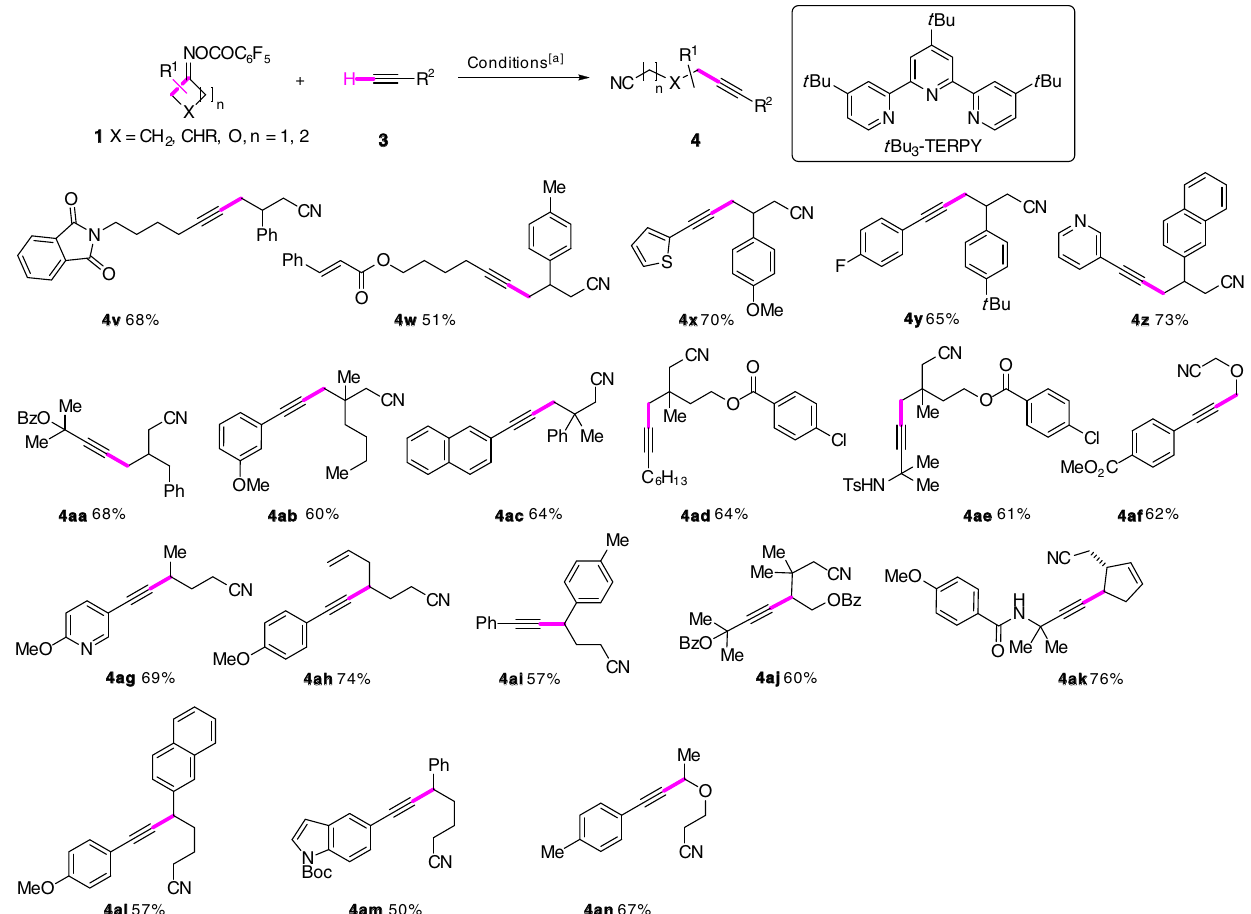
Fig. 3 Cu-catalyzed reductive coupling of oxime esters derived from cycloalkanone derivatives. [a] 1 (0.2 mmol), 3 (0.4 mmol), CuI (0.1 equiv), t Bu 3 - TERPY (0.2 equiv), K 2 CO 3 (2.0 equiv), CH 3 CN (1.0 mL, c 0.2 M), 60 °C, under nitrogen atmosphere. Yields refer to the isolated